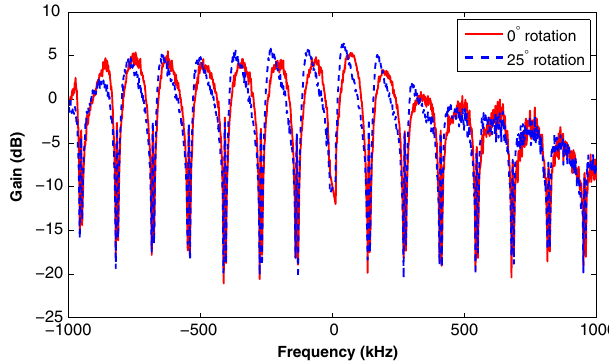
FIG. 18. (Color) Measured transfer function magnitude from LER 4-5 at 1200 mA showing minimal comb rotation induced distortion with the improved